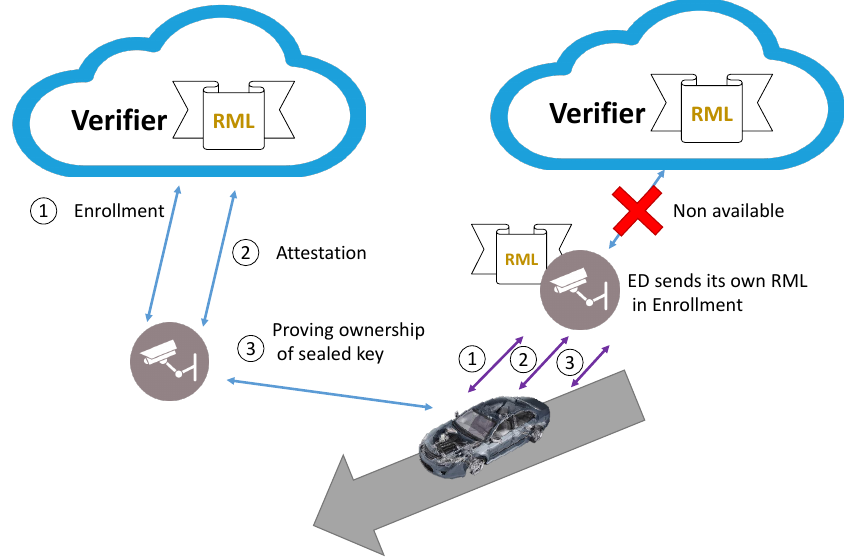
Figure 7. Visualization of the two use cases, edge computing as service (in blue) and edge computing as service—No TTP online (in